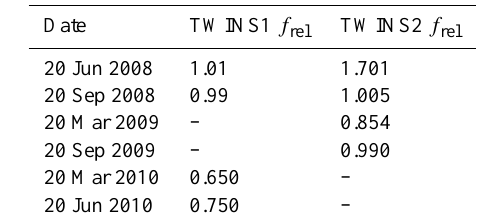
Table 1. Measured, relative calibration factors f rel = I LAD1 /I LAD2 at the actuator’s turning points of both LADs for TWINS1/2 and different